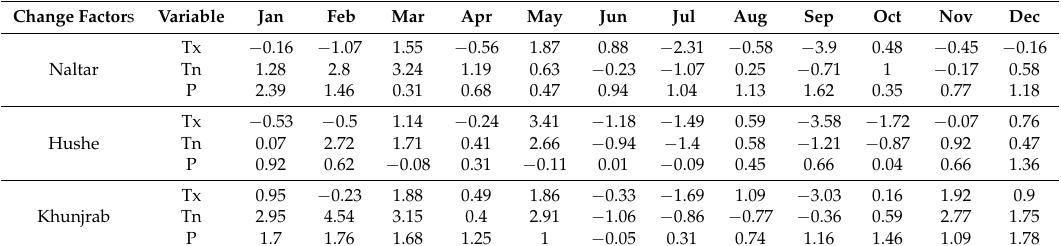
Table 4. Monthly change factors derived for the period 2013–2030 relative to 1995–2012 for devising a near-future